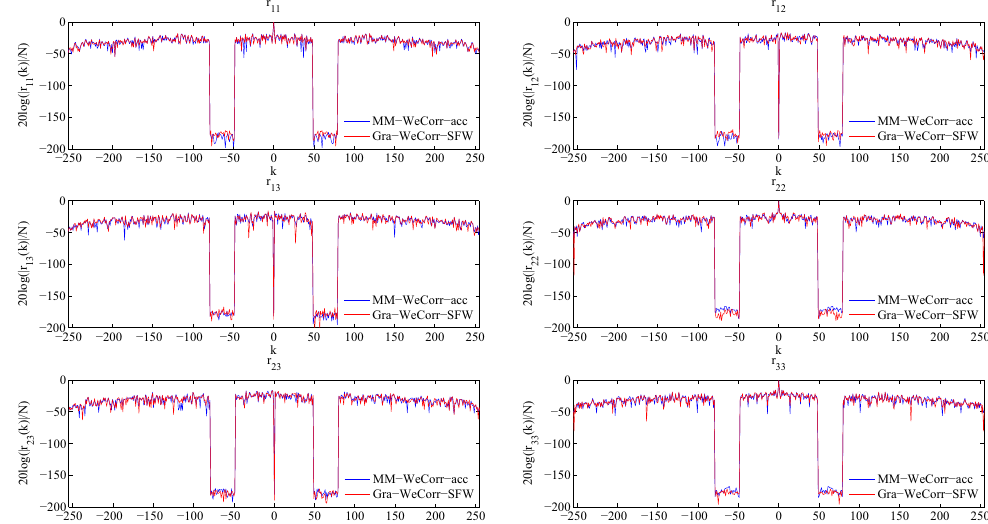
Figure 5. The normalized auto- and cross-correlations of the waveform sets designed by MM-WeCorr-acc and Gra-WeCorr-SFW. ( ε = 10 − 10 ) .